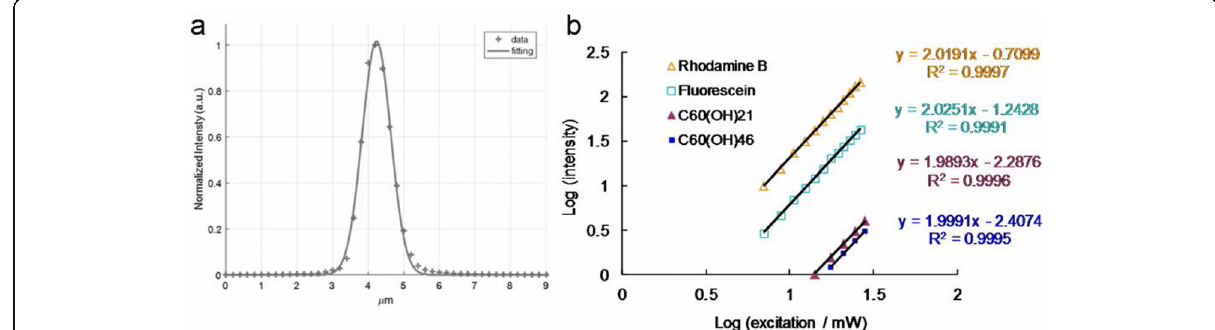
Fig. 1 a According to the z -axis scan of a gold thin film used to measure the signal of second harmonic generation at different positions, the z - axis resolution of the laser system (full width at half maximum) is approximately 0.90159 μ m (fitting using Gaussian function). b TPL intensity dependence on the excitation power (logarithm) of the materials and fluorophores; TPE exposure from 704.0 to 2816.0 nJ pixel − 1 for Rhodamine B and fluorescein, from 1408.0 to 2816.0 nJ pixel − 1 for water-soluble C 60 (OH) 21 fullerenol, and from 1760.0 to 2816.0 nJ pixel − 1 for water-soluble C 60 (OH) 46 fullerenol. Excitation wavelength, 760 nm. Delivered dose: OD 600 0.05 of E. coli and 3 μ g mL − 1 materials. Data are presented as means ± SD ( n =